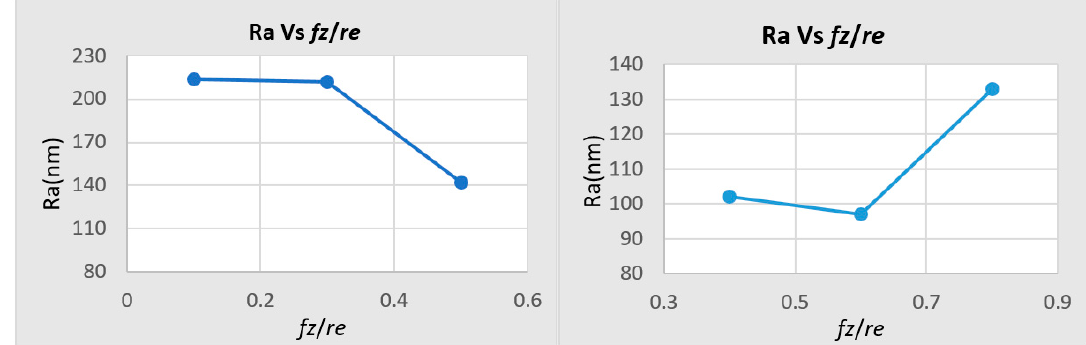
Figure 5. Comparison for the main effect plot for Ra vs. undeformed chip thickness ( f z) to cutting-edge radius ( r e) ( f z/ r e) with the literature [81] (with the permission of Elsevier).